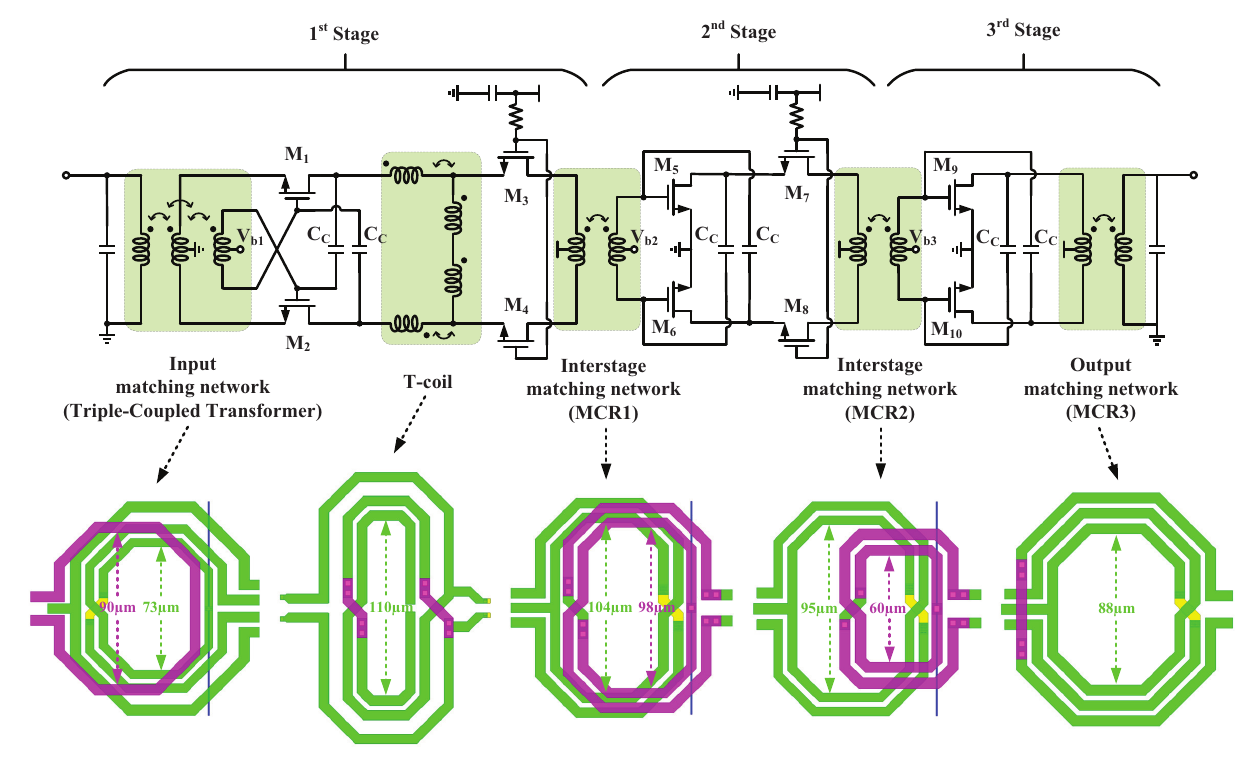
Figure 1. The schematic of the proposed broadband LNA and all passive devices’ 3D